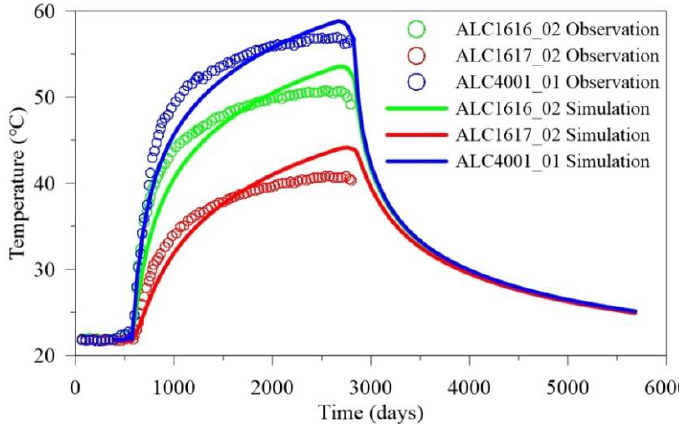
Figure 10. Comparison of temperature evolution between the measurements and numerical results at sensors in three monitoring boreholes.